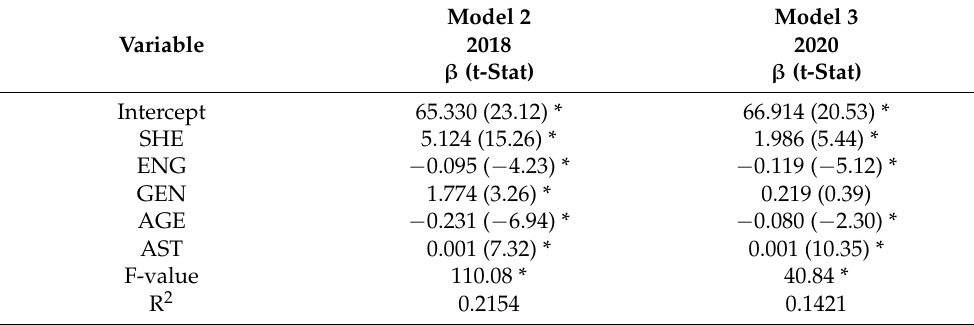
Table 5. Results of hypotheses testing: subsample analysis (N 2018 = 2011; N 2020 = 1868).